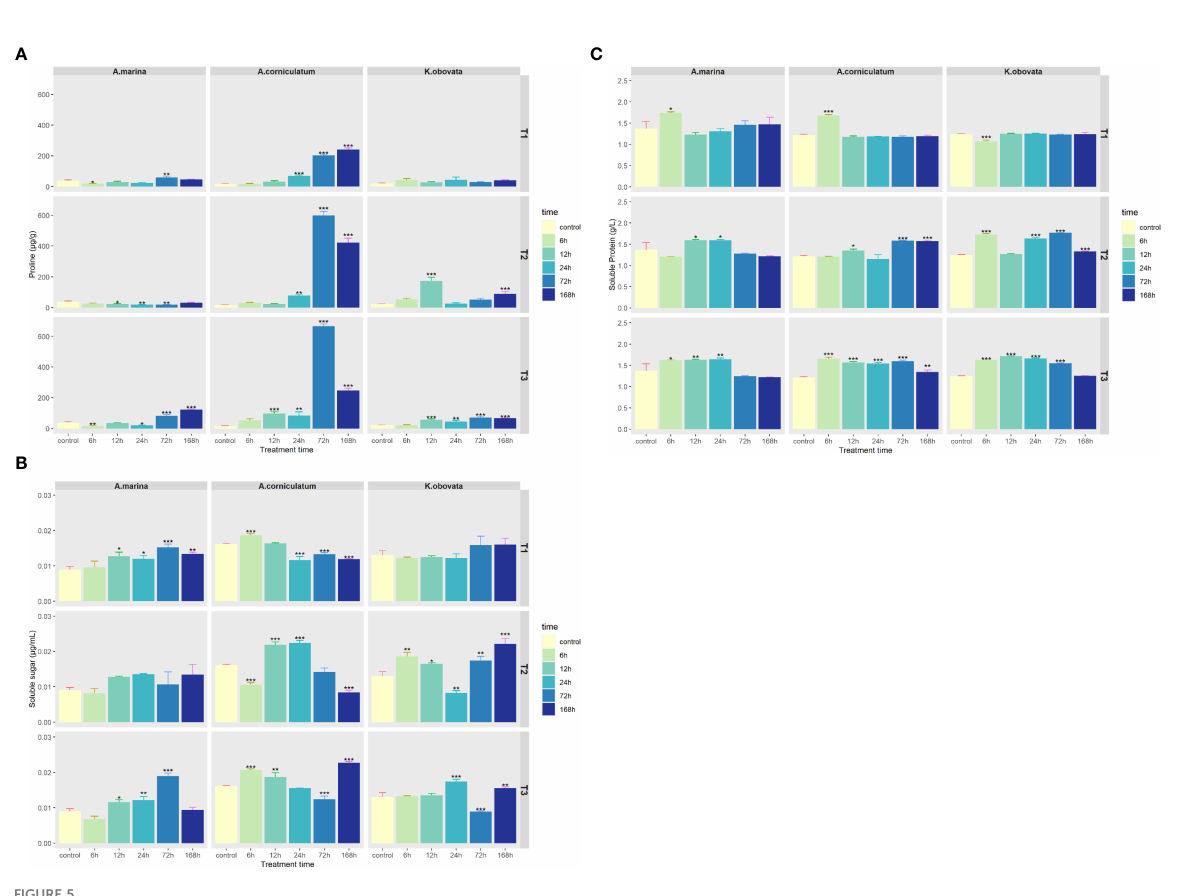
FIGURE 5 Changes of (A) proline, (B) Soluble sugar and (C) Soluble protein contents under upwelling stress. * indicates that there are signi fi cant differences between control and treatment groups [p<0.05(*), p<0.01(**), p<0.001(***)]. “ T1 ” means 5 ℃ upwelling stress, “ T2 ” means 10 ℃ upwelling stress and “ T3 ” means 15 ℃ upwelling